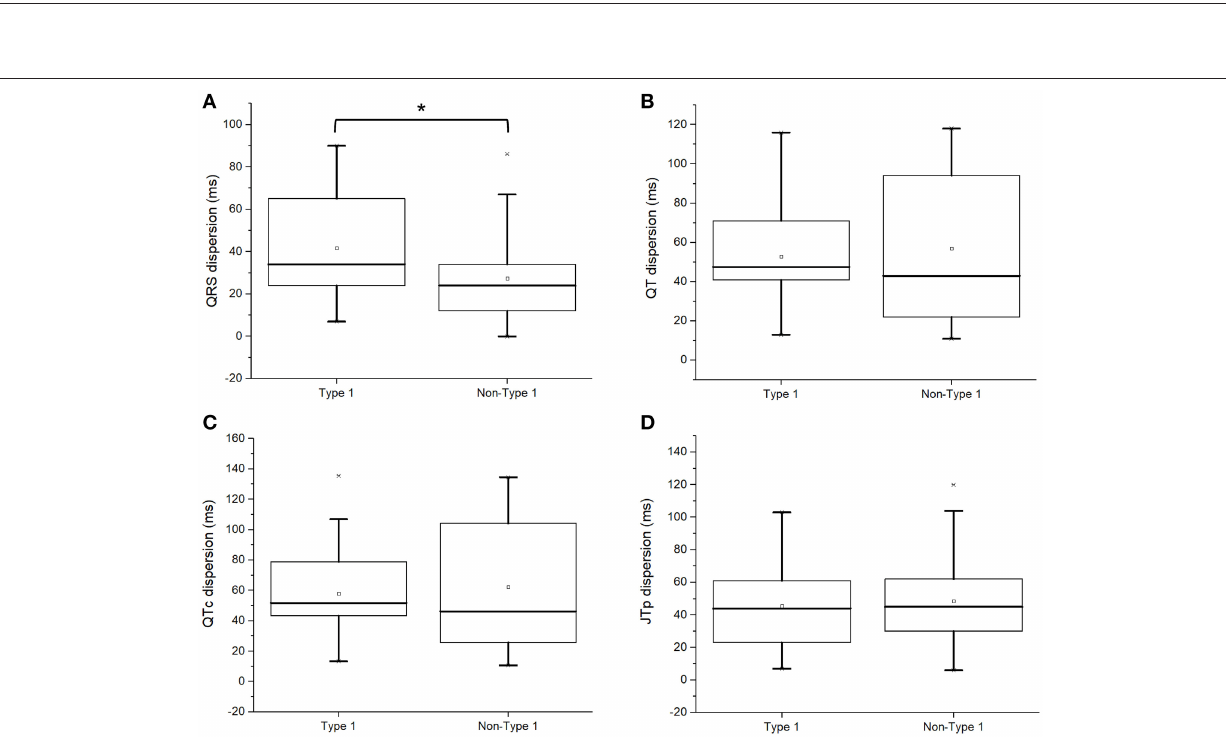
Frontiers in Cardiovascular Medicine | www.frontiersin.org